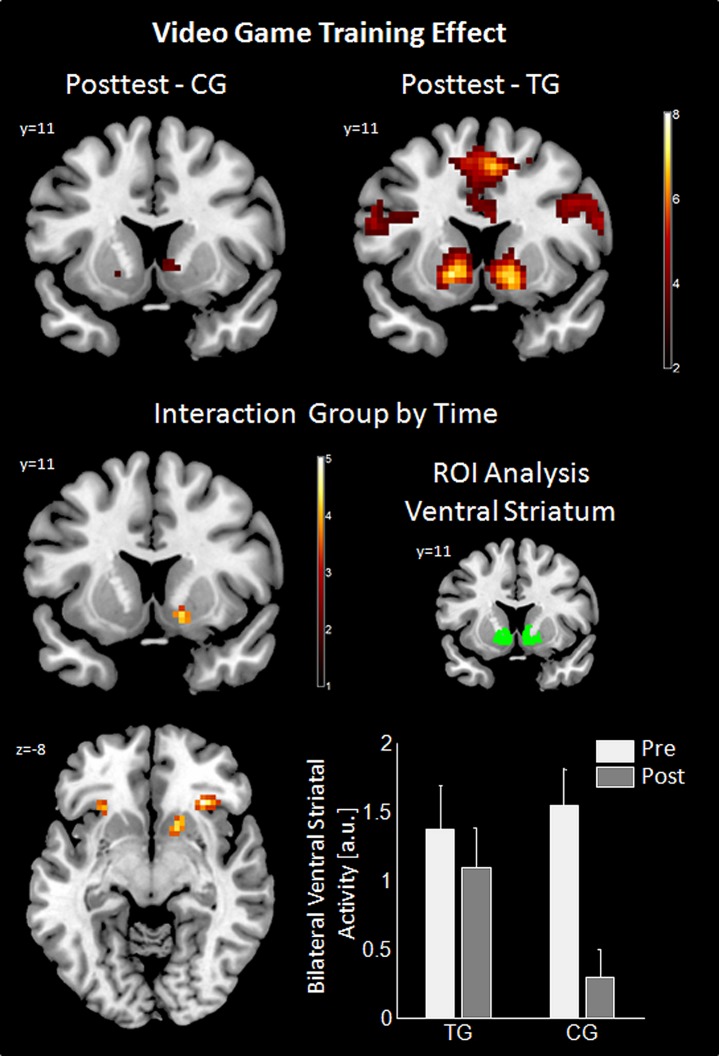
Results of video game training effect. For posttest the effect of gain anticipation (XX_) against no gain anticipation (XY_) is shown using a coronal cut (Y = 11) in the upper row for control group (CG) and training group (TG). Imaging results of the interaction group by time are shown in the middle and bottom left panel (axial cut at Z = -8). ROI analysis for this interaction is in the middle (literature-based ROI in green) and bottom (bar graph of the ROI analysis displayed with standard error of means) right panel. Imaging results are threshold with p < 0.05, Monte Carlo corrected. ROI, region of interest; a.u., arbitrary units.